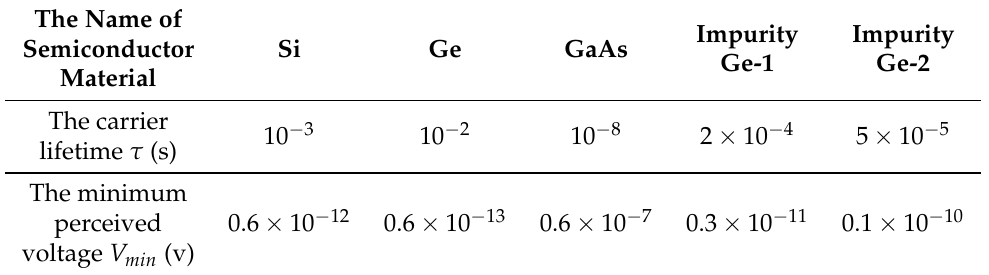
Table 1. The carrier lifetime and their minimum perceived voltage of different semiconductor